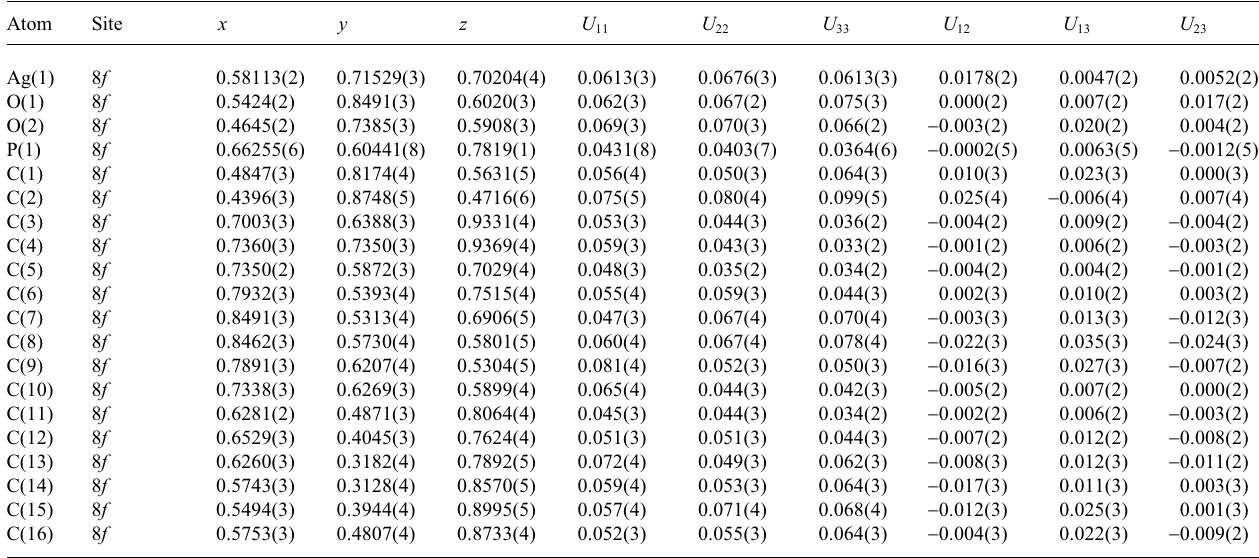
Table 3. Atomic coordinates and displacement parameters (in Å 2